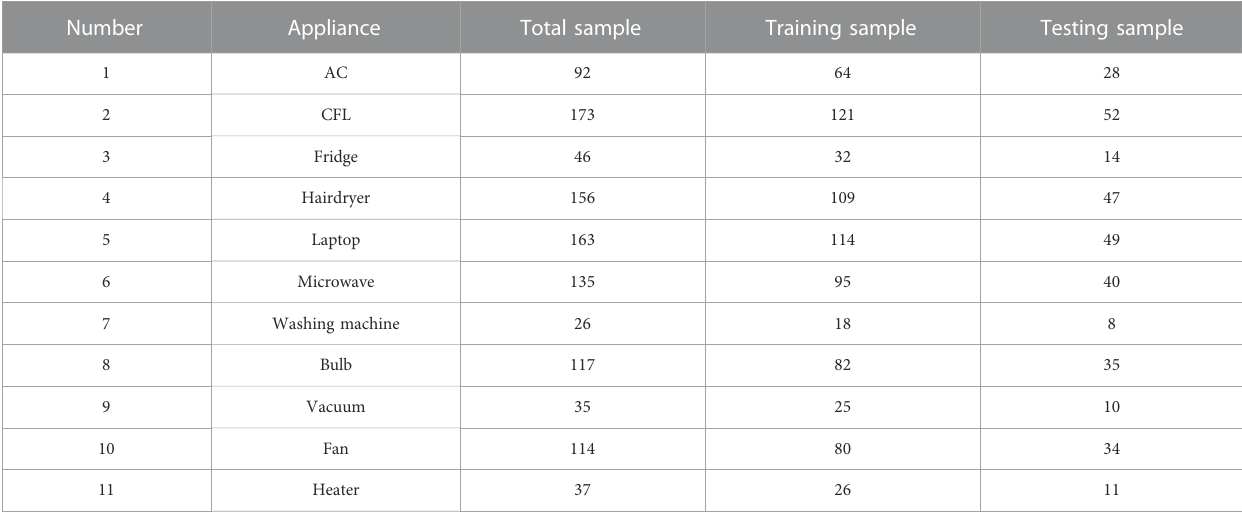
TABLE 1 Distribution of the